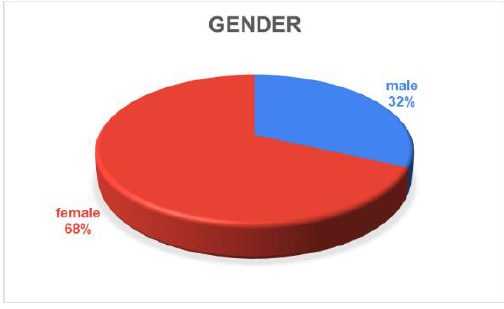
Figure 1. Gender Distribution